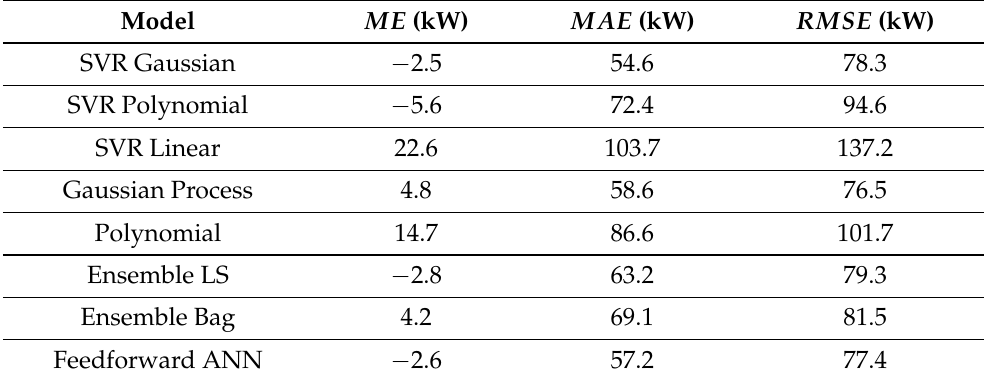
Table 5. Error metrics for testing of different model types for the blade pitch–power regression in Region 2 1 / 2 : WF1, average of the wind farm.